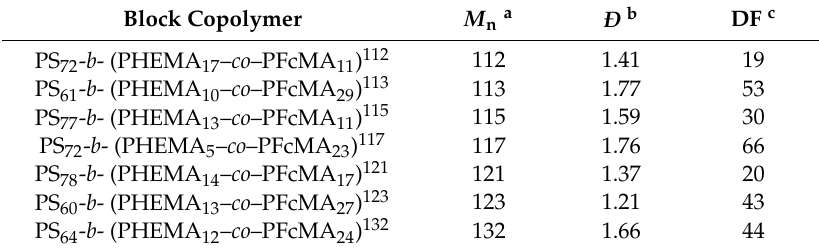
Table 2. Characterization of ferrocene-functionalized block copolymers PS- b - (PHEMA– co –PFcMA) via SEC measurements and 1 H NMR spectroscopy.